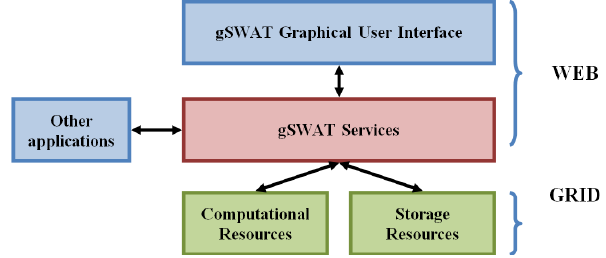
Fig. 4. Functional layers of the gSWAT